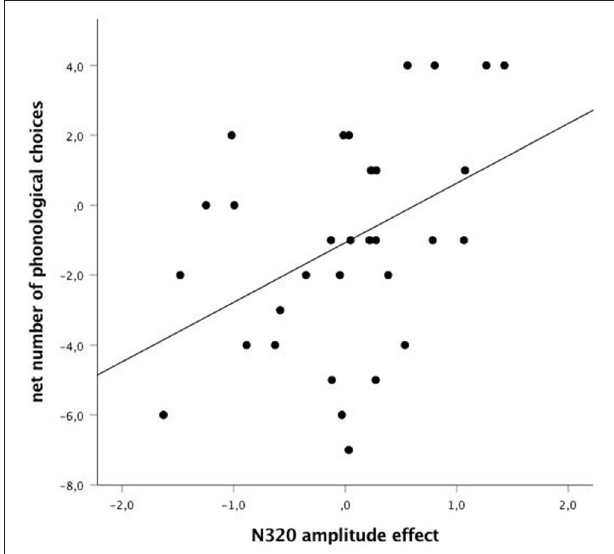
FIGURE 3 | Net number of phonological choices by N320 amplitude effect (experimental—control) at the mid-left of the brain (average of F P1 , F 3 , F Z , C Z , T 3 , T 5 , P Z , and P 3 ); r = 0.43; p = 0.017); N = 31. The more positive the N320 amplitude effect (i.e., the more negative the N320 amplitude in control trials as compared to experimental trials), the more net phonological choices.